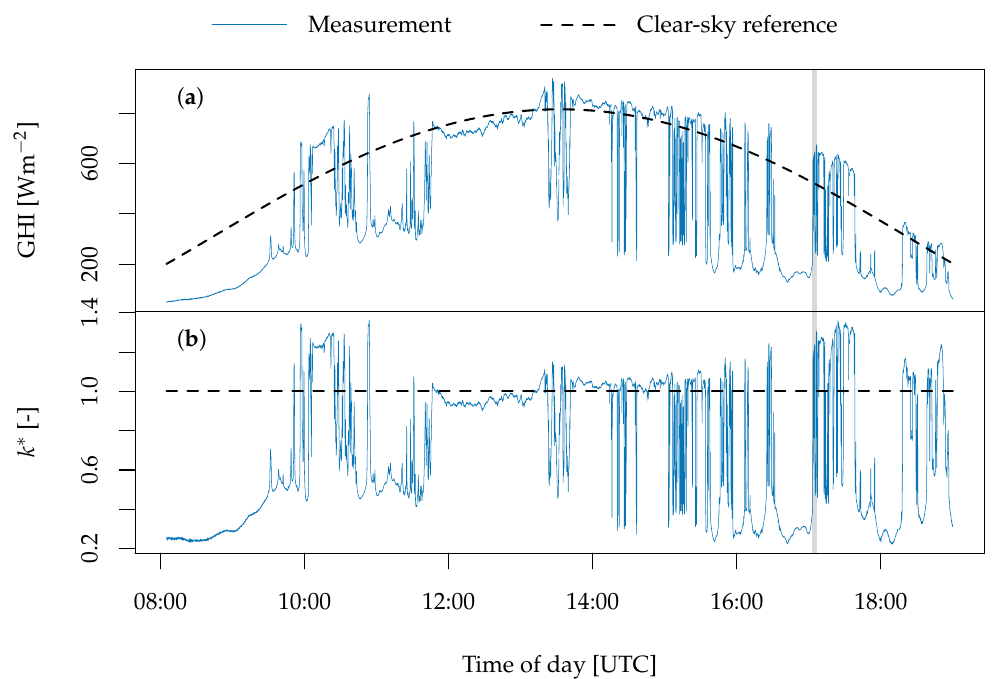
Figure 1. ( a ) An example of a diurnal cycle of measured global horizontal irradiance (GHI) along with simulated clear-sky irradiance derived by a basic model [140]; ( b ) A corresponding clear-sky index estimate k ∗ according to Equation (2). The irradiance data were measured during the HD(CP)2 Observational Prototype Experiment (HOPE) campaign [138,139] with 1s temporal resolution near Jülich, Germany, on 25 April 2013, and have been conditioned to exclude times of low solar elevation angles α < 15 ◦ after sunrise and before